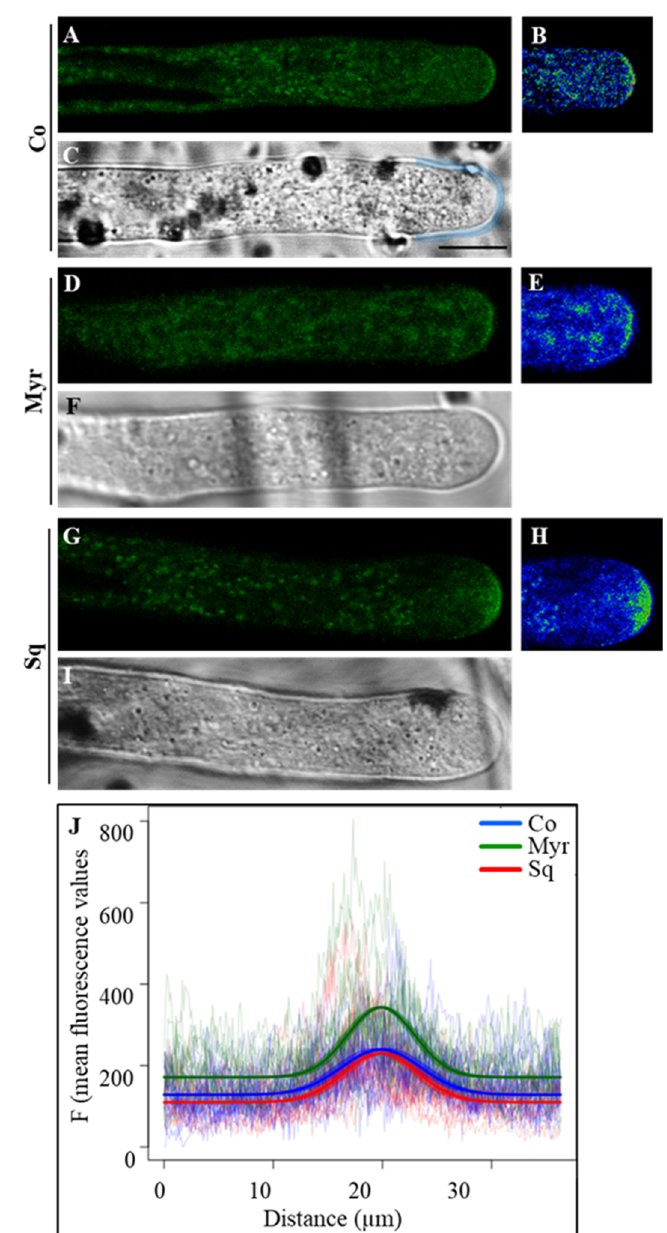
Figure 6. Effect of myriocin and squalestatin on NtPPME1 secretion. Pollen grains were transiently transformed using a plasmid which codifies for the fusion protein LAT52- NtPPME1-EGFP. In control and treated pollen tubes, NtPPME1 localized in the apical dome and in unidentified organelles inside the cell (( A , D , G ) LAT52- NtPPME1-EGFP; ( B , E , H ) pseudo-colored images; ( C , D , G ) bright field for control myriocin and squalestatin pollen tubes, respectively). In squalestatin-treated pollen tubes the accumulation of NtPPME1 positive vesicles immediately behind the PM was observed ( G , H ). Quantitative analysis performed by ImageJ was expressed as plot profile in the apex of pollen tubes ( J ); starting about 20 μ m from the tip using a freehand line as in ( C ) blue line; n > 18) and confirmed that NtPPME1 localized in the apical dome. Myriocin peak appeared narrower than control profile (( J ); compare blue and red lines, p < 0.01) while squalestatin treatment induces a sharp rise of the peak in the apical dome (( J ); compare blue and green lines; p < 0.01). Plot profile analyses revealed that in the shank, mean fluorescence was significantly lower in myriocin and significantly higher in squalestatin-treated pollen tubes compared to control (( J ); ANOVA and Tukey’s post hoc test: p < 0.001). Bright field images ( F,I ). Scale bars = 10 μ m.